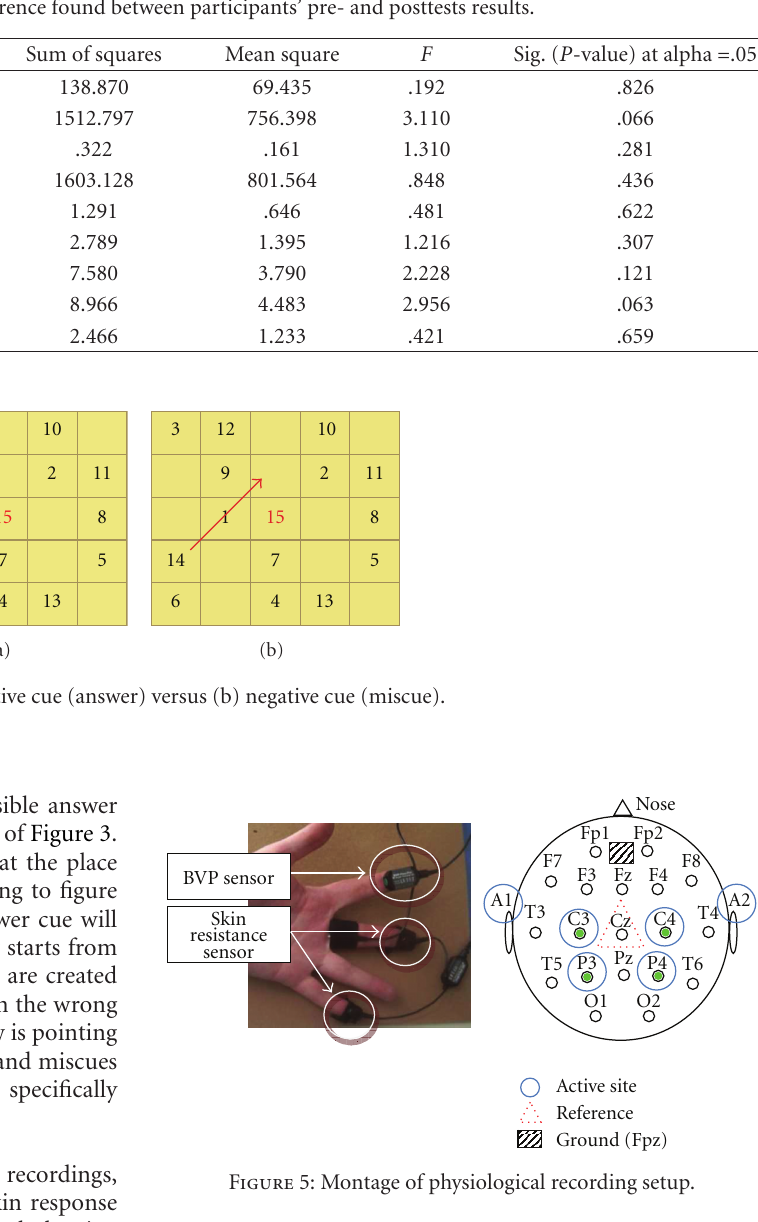
normalize the data. Most eye blinks and eye movement artifacts occur dominantly between 0,1 and 4 Hz band and thus were eliminated by a proper band-pass filter as